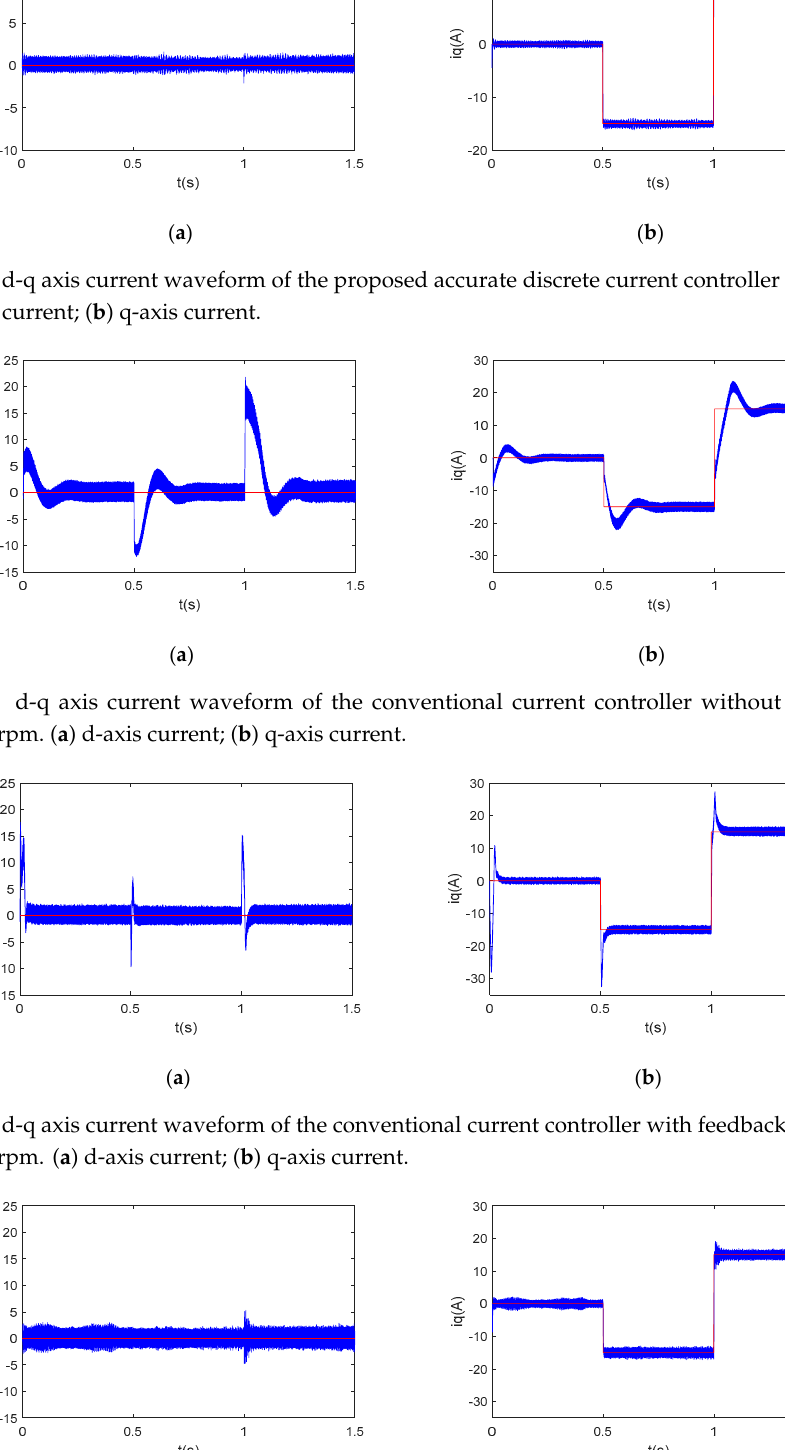
Figure 10. d-q axis current waveform of the proposed accurate discrete current controller at 12,000 rpm.